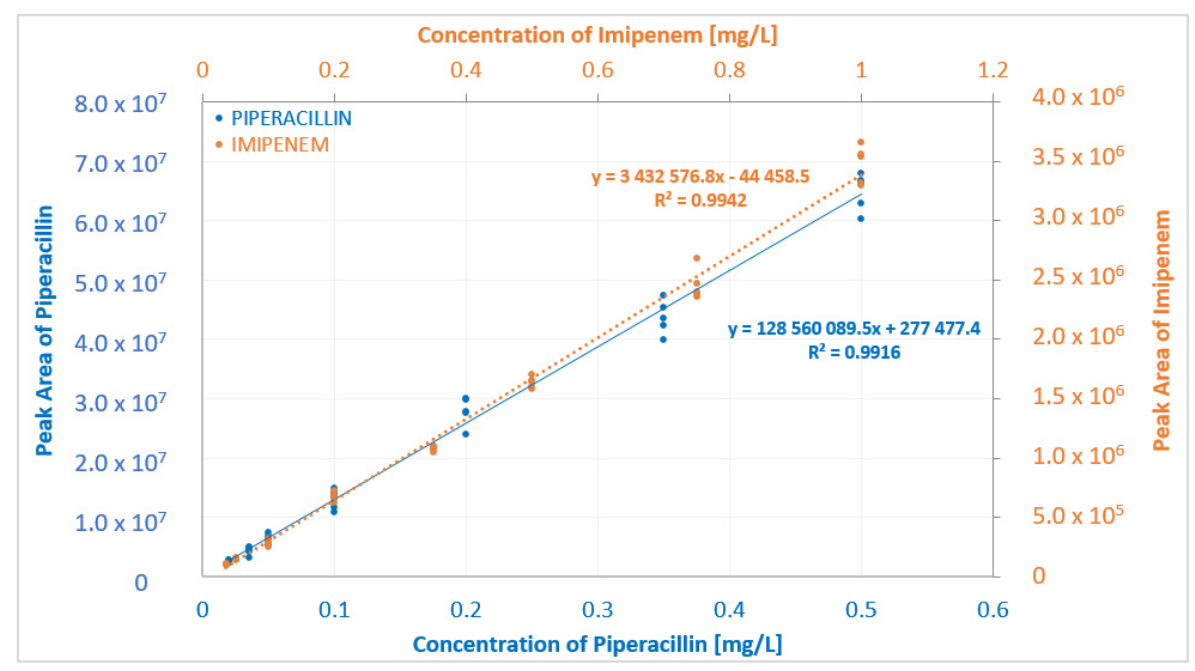
Figure 4. Calibration curves for extraction of imipenem and piperacillin from human blood plasma. Table 3. Within- and between-run accuracy presented as the percent of nominal concentration of the analyte.